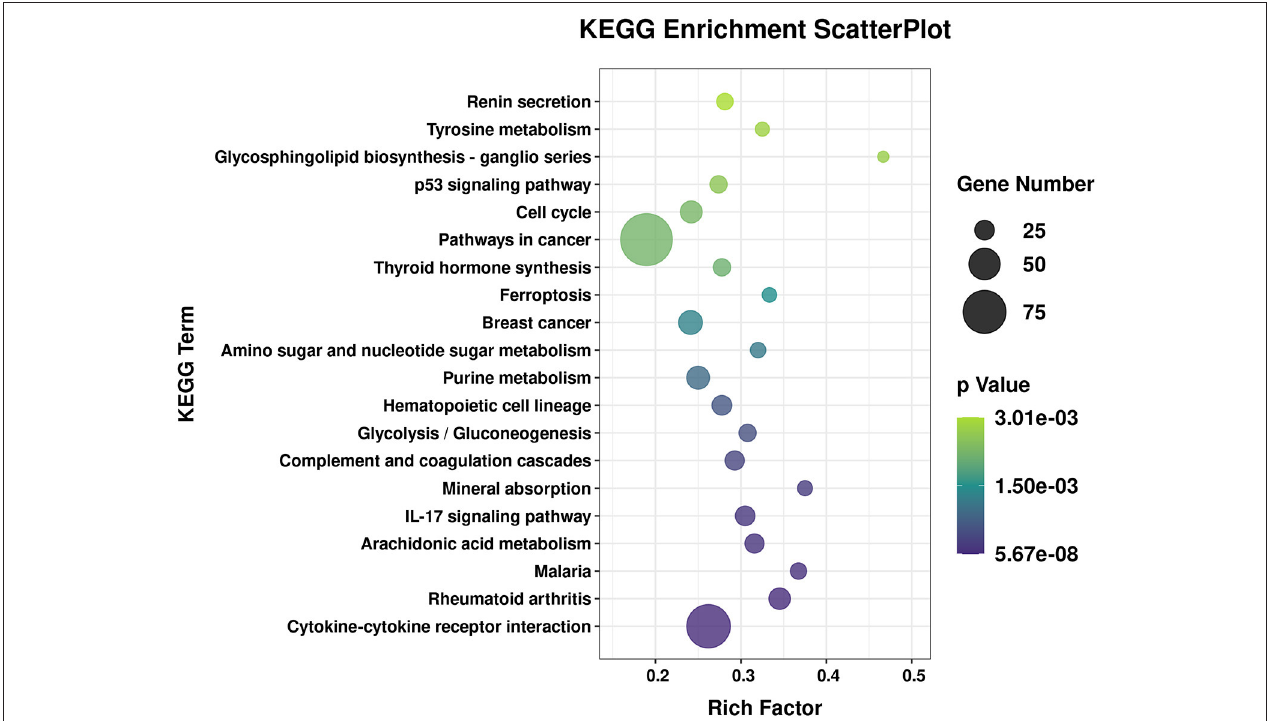
FIGURE 4 | Top 20 of the enriched Kyoto Encyclopedia of Genes and Genomes (KEGG) pathways of the differentially expressed RNA molecules. The x-axis indicates the enrichment factor, and the y-axis indicates the name of the KEGG pathway. The size and color of the dot indicate the number of target genes and the p -value (Fisher’s exact test), respectively. The enrichment factor indicates the number of differentially expressed genes/total genes for each KEGG